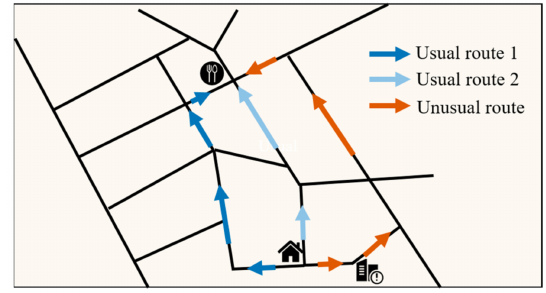
Figure 6. Schematic of an unusual